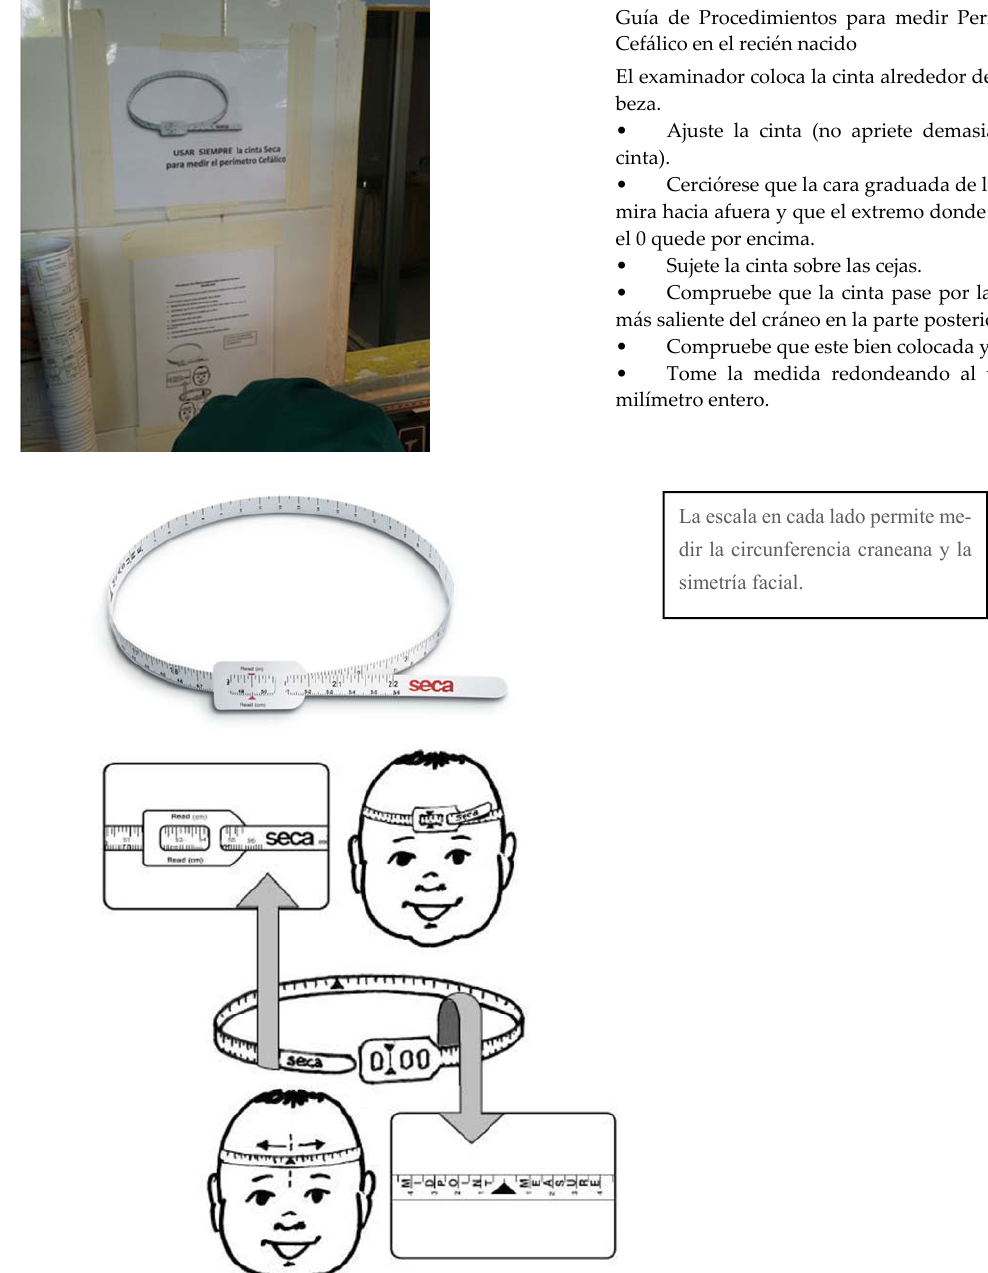
Figure 1. Instructions for use of SECA 212 insertion tapes posted in the room where newborns were measured, Zika in Pregnancy in Honduras (ZIPH) (2016). Hospital Escuela, Tegucigalpa, Honduras. Sign translates, “Always use the Seca tape to measure head circumference.”